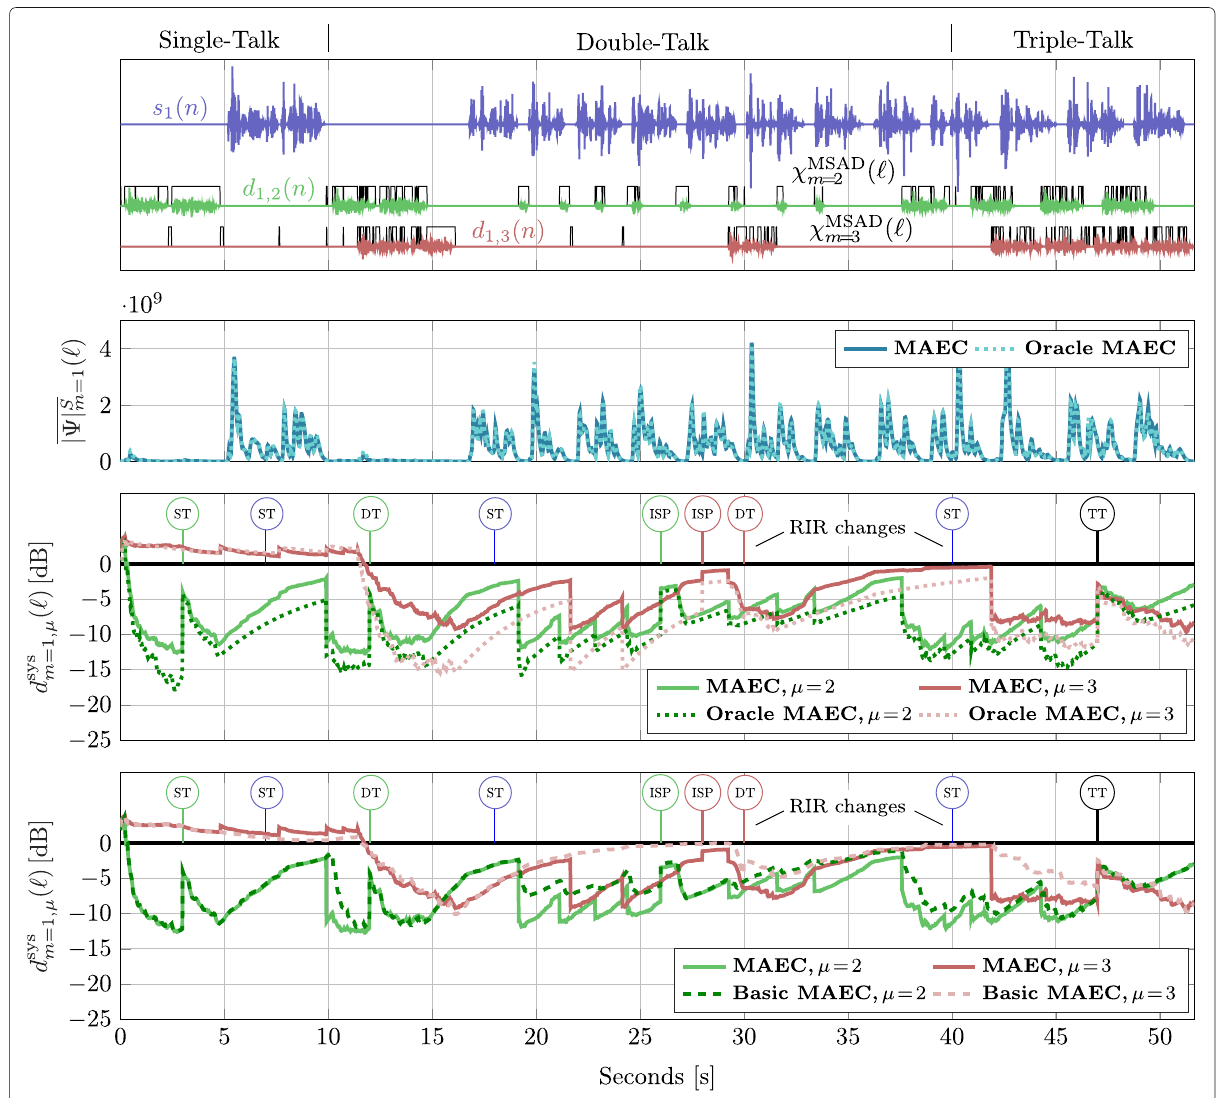
Fig. 8 Comparison of the averaged and time-smoothed measurement noise | (cid:9) | S m = 1 ((cid:4)) and the system distance d sys m = 1, μ ((cid:4)) of the MAEC and the oracle MAEC, respectively, for one specific dialog at iSIR = 10dB. From top to bottom the target speech signal s 1 ( n ) , both interferer speech signals d 1, μ = 2 ( n ) and d 1, μ = 3 ( n ) are visualized with the corresponding MSAD output χ MSAD m ((cid:4)) ∈ { 0,1 } . The measurement noise component | (cid:9) | S m = 1 ((cid:4)) of the MAEC and oracle MAEC are denoted with a blue solid line and a dotted skyblue line, respectively. Finally, the associated system distance d sys m = 1, μ ((cid:4)) of both interferer signals μ ∈ { 2,3 } are colored according to the interfering signals, whereby dotted lines represent the results of the oracle MAEC, dashed lines the results of the basic MAEC without using the extended RIR update control strategy, and solid lines the results of the MAEC using the extended RIR update control strategy. Figure best seen on the